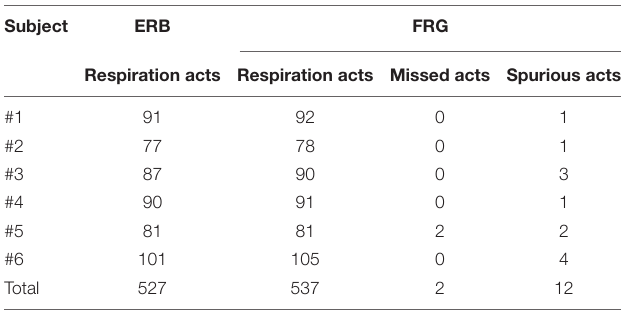
TABLE 1 | Respiration acts detected in the ERB and in the FRG extracted from the raw piezoelectric sensor signal.